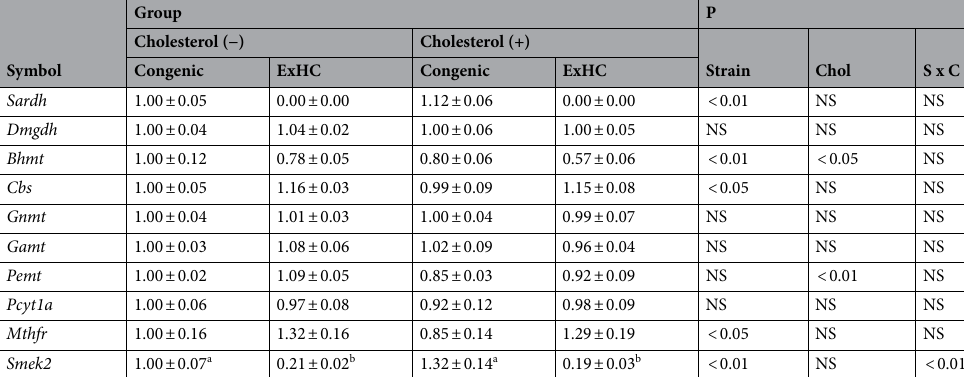
Table 3. Hepatic mRNA expression in ExHC and congenic rats. Values are shown as means ± SEM. n = 6/ group, Mean value of cholesterol (−) -congenic rats was set to 1.00. The Gusb gene was as the internal standard. Differences for each gene were detected by two-way ANOVA followed by Tukey–Kramer post-hoc test and were considered significant at P < 0.05. NS in the table is the abbreviation for “not significant”. a,b,c Significant differences between groups with different letters at P <